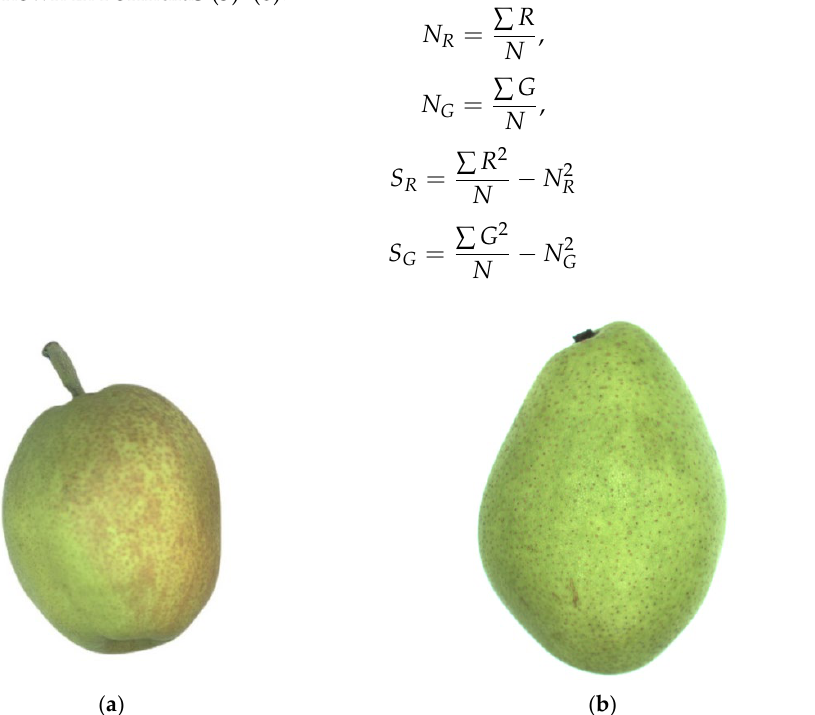
Figure 4. Surface color of pears. ( a ) Standard color. ( b ) Deviant color.